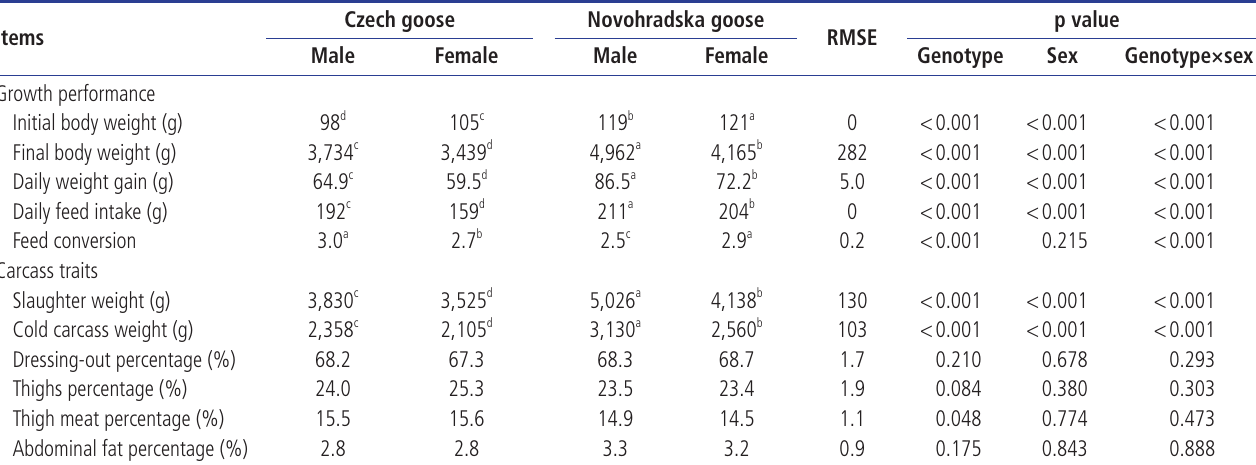
Table 2. Growth performance and carcass traits as affected by genotype and sex